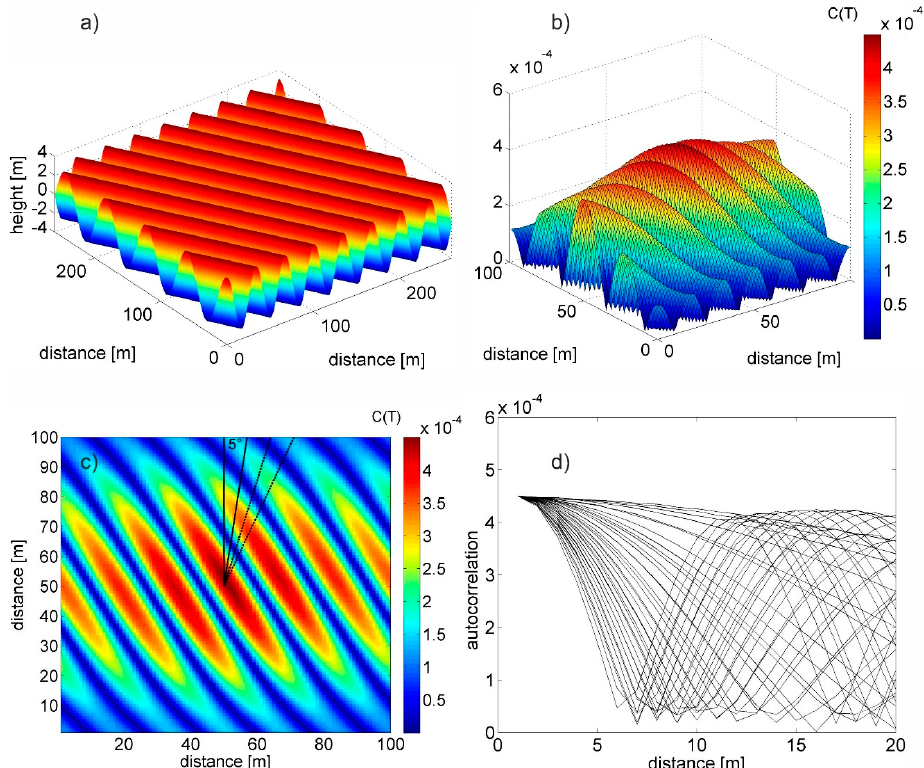
Figure 5. ( a ) Artificially generated surface with a regular, sinusoidal shape and spatial frequency of 0.033 m − 1 ; ( b ) the autocorrelation function for the sinusoidal surface in the moving window with a side length of 100 units; ( c ) determination of cross-sections through the 2D autocorrelation function, every 5 ◦ ; ( d ) cross-sections of the 2D autocorrelation function in the window with a side length of 100 units, every 5 ◦ .